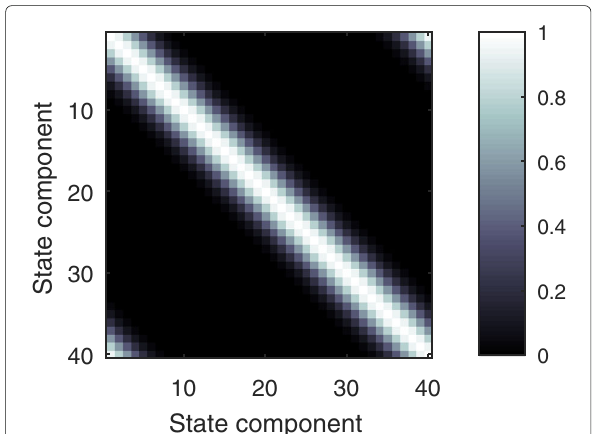
Fig. 17 The employed tapering matrix ρ